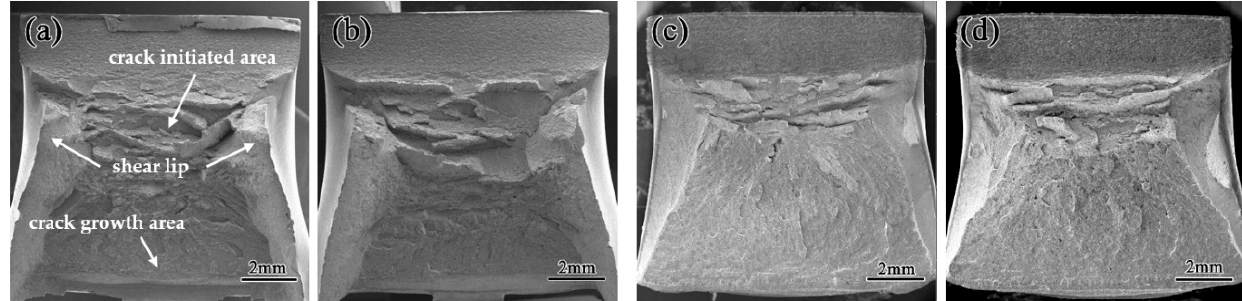
Figure 3. Low magnification fractographs of S1 and S2 samples after Charpy impact at room temperature ( a ) S1 before aging; ( b ) S2 before aging; ( c ) S1 aging 97 h at 580 °C; and ( d ) S2 aging 97 h at 580 °C. Table 2. Proportion of crack-initiated area.